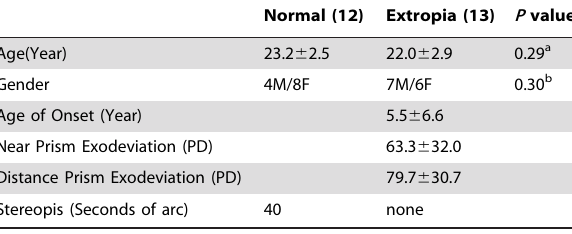
Table 1. Clinical